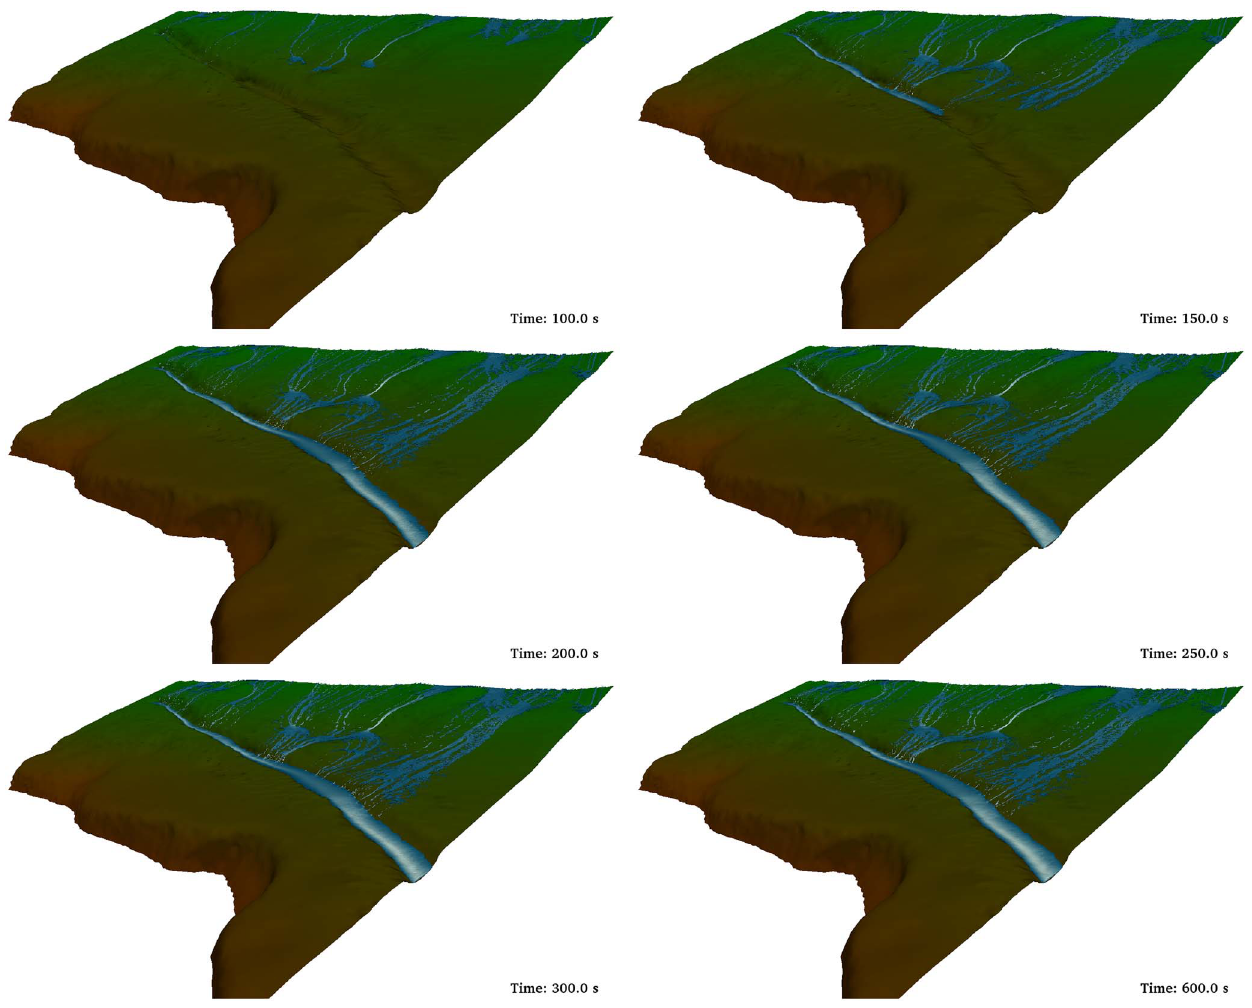
Figure 9. Different instants of the DualSPHysics simulation with a ditch 0.8 m deep. Additional detail about the simulation can be found at